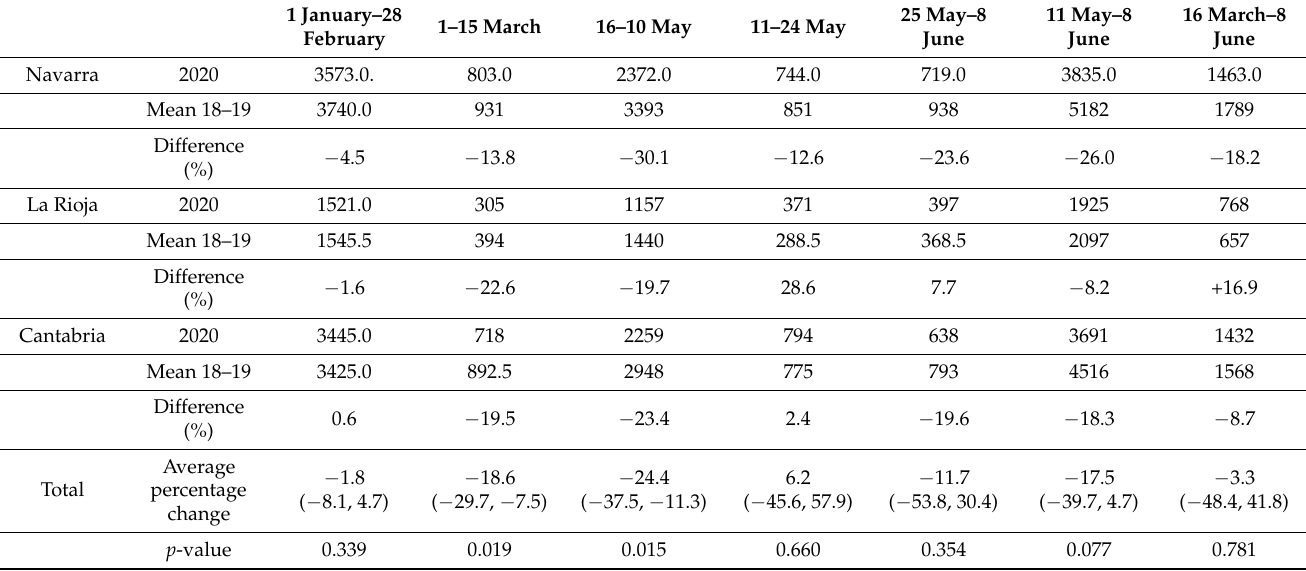
Table A1. Distribution of packed red blood cells from the transfusion